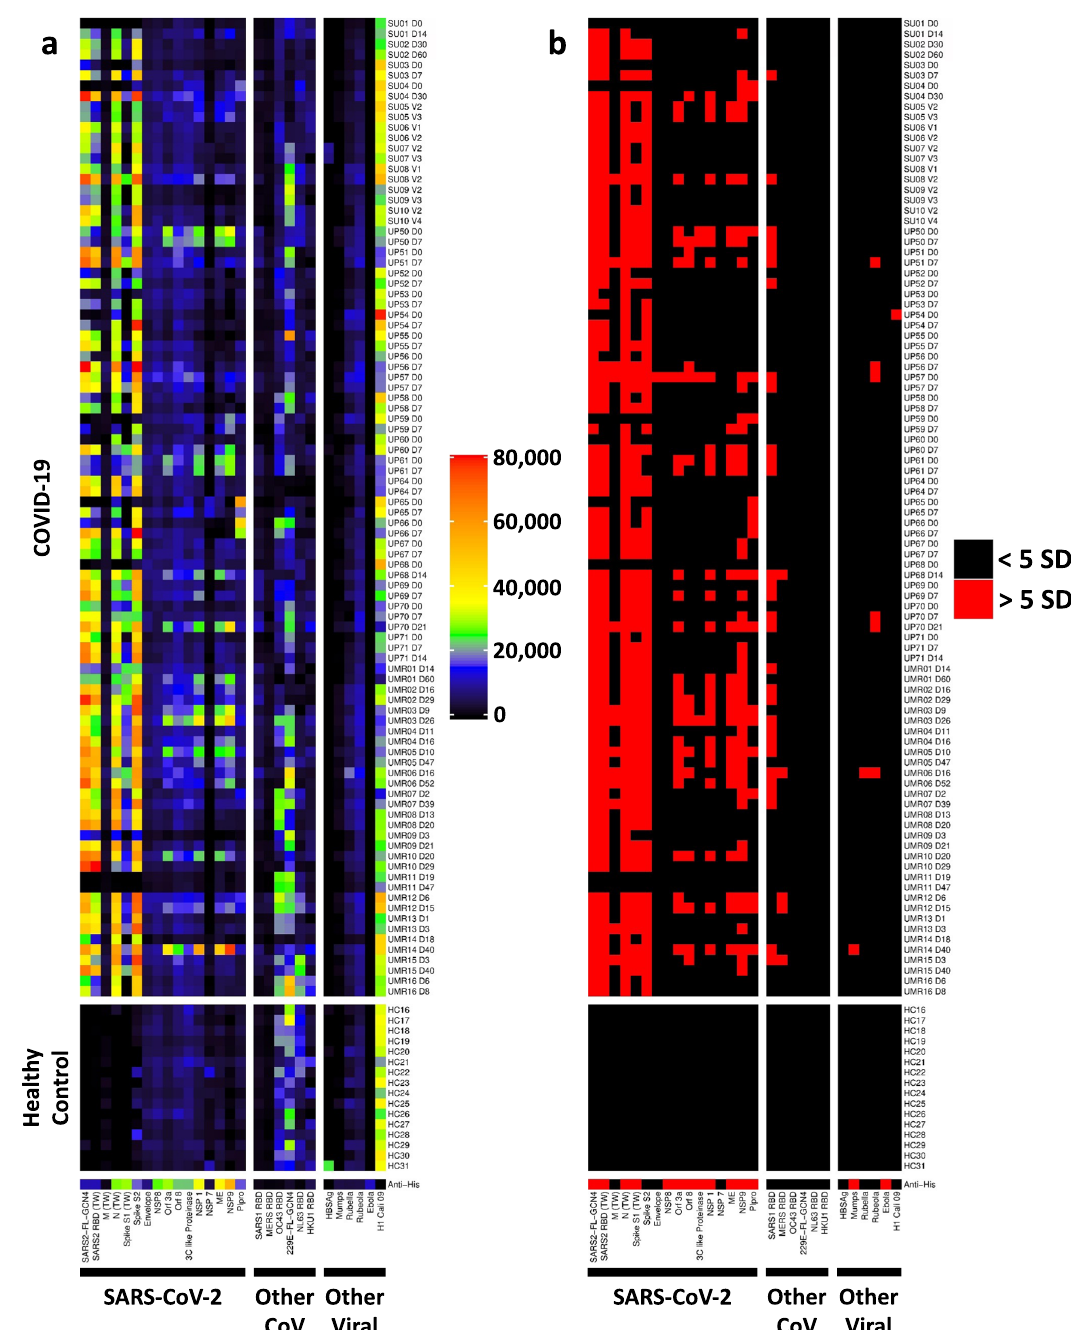
Fig. 4 Measurement of anti-viral IgG responses using a COVID-19 viral array. a Heatmap depicting IgG antibodies using a 28-plex bead-based protein array. Viral protein antigens are grouped based on sixteen proteins from SARS-CoV-2 (left panel), other coronaviruses (middle panel), and other viruses (right panel), labeled on the x-axis. Most recombinant viral proteins were engineered to include a 6X-His-tag, which was used to validate conjugation to beads using an anti-epitope monoclonal antibody (bottom of the panel). The same COVID-19 patients from Fig. 3 (see Supplementary Figures 9 and 10) were analyzed (top panel, n = 94 longitudinal COVID-19 samples, including paired samples from 44 subjects and 2 subjects who had 3 available time points each, subjects UP70 and UP71). HC ( n = 16, middle panel). Two patient sample pairs (UP63 and UMR20) were excluded from analysis due to technical failure on the viral array assay. Colors correspond to the MFI values shown at right. b Heatmap depicting statistically signi fi cant anti-viral IgG responses. Colors indicate IgG antibodies whose MFI measurements are >5 SD (red) or <5 SD (black) above the average MFI for HC samples collected prior to the COVID-19 pandemic. Source data are provided as a Source Data fi